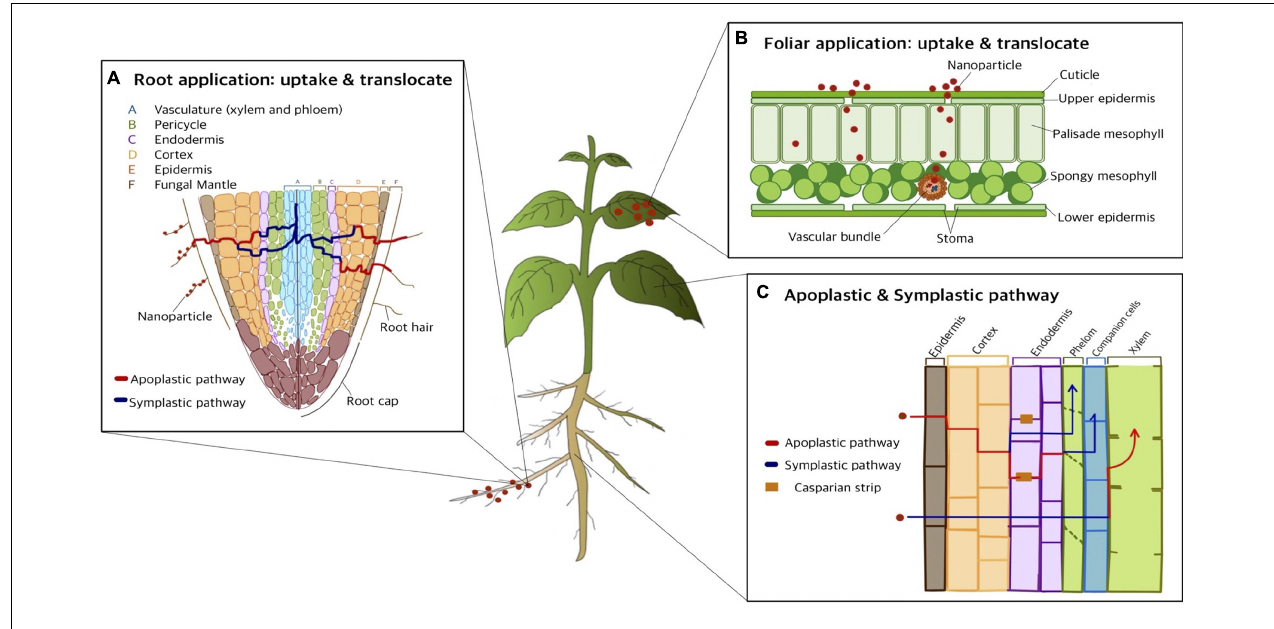
FIGURE 4 | Nanoparticle uptake and translocation in living plant: pathway of foliar spray and root application (modified from Pérez-de-Luque, 2017). (A) Root application: uptake and translocate. There are two pathways for uptake and transport of nanoparticles once the nanoparticles traverse the root hair: apoplastic pathway and symplastic pathway. (B) Foliar application: uptake and translocate. Nanoparticle can be applied via foliar spraying method allowing to uptake and accumulate the nanoparticle into leaves efficiently. (C) Apoplastic and symplastic pathway. When nanoparticles approach the root epidermis, two major pathways have been previously investigated: apoplast and symplast pathway. These allow the translocation of nanoparticles towards non-photosynthetic tissues and